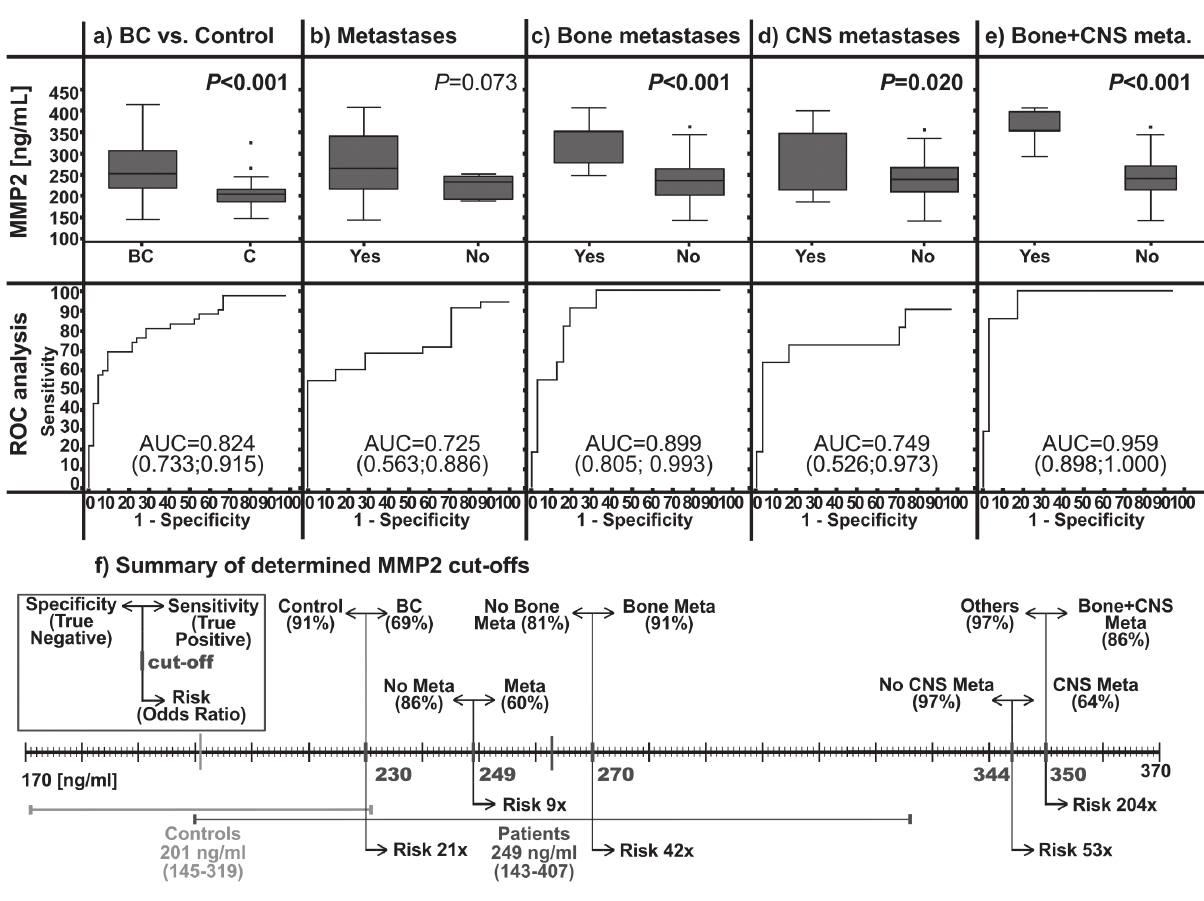
Fig. 2. Serum levels and ROC analysis of MMP-2 in the HER2 BC patients